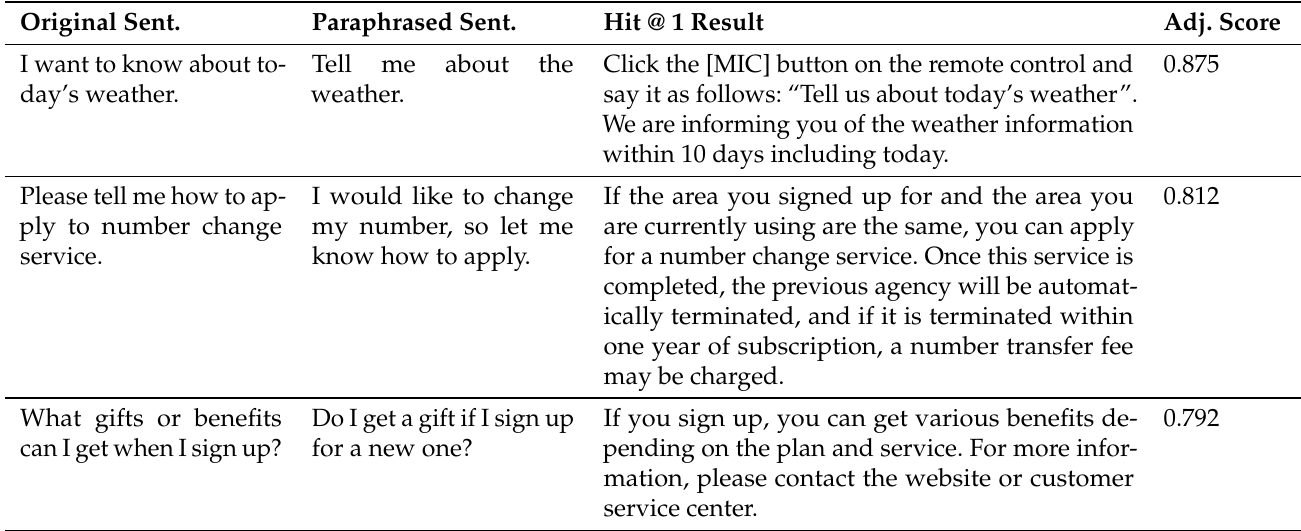
Table 5. Actual example sentences of the FAQ database and paraphrased query. Paraphrased Sent. refers to the reconstructed input query sentence, and Adj. score means the sum of the scores of the two retriever models with arctangent and Q-blending